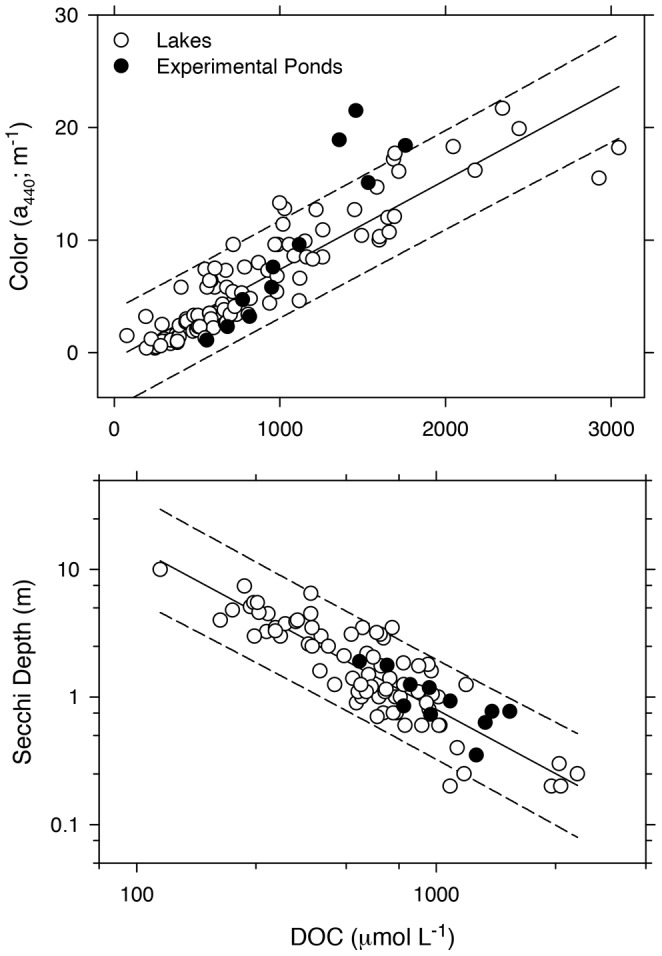
Super Hume effects on the aquatic light-environment.Comparison of color (A) and Secchi depth (B) as a function of DOC in natural lakes and experimental ponds. Variation in DOC concentration in the experimental ponds was achieved by manipulating the Super Hume supply rate. Regression lines represent predicted values and 95% prediction intervals.